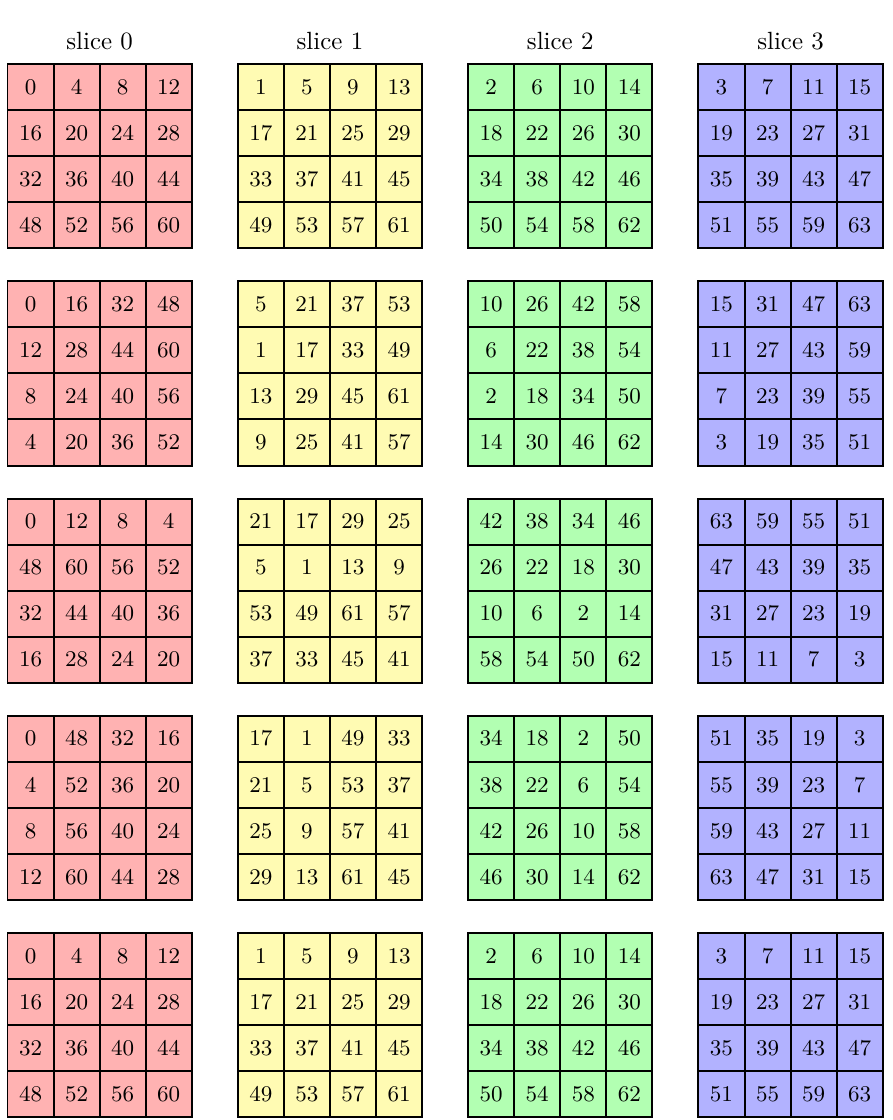
Figure 3: Classical representation of the GIFT-64 round function during 4 rounds. Each cell represents a bit, and the numbers in the cells then denote the actual index of that particular bit in the state. Slice 0 (resp. 1/2/3) depicted in red (resp. yellow/green/blue) represents all the bits at position 0 (resp. 1/2/3) of the S-boxes of the cipher